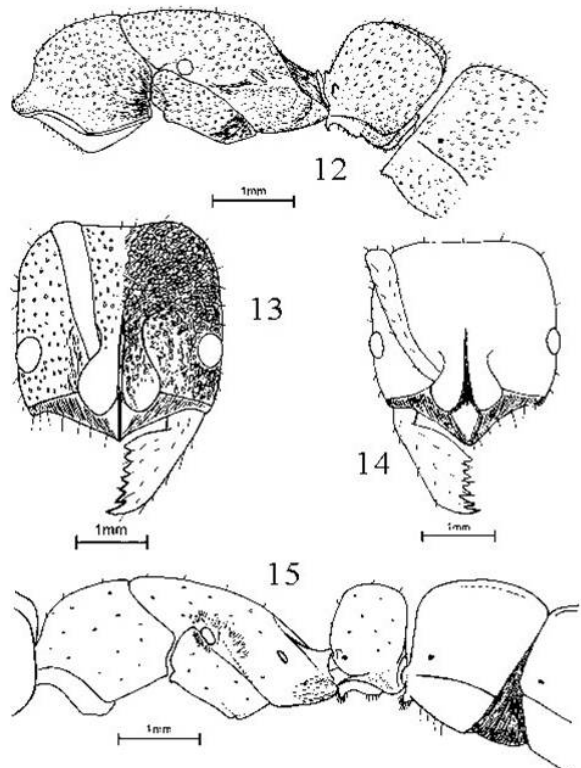
Fig 12 . The lateral view of worker of B. granosa (AMNH). Fig 13 . The head of worker of B. granosa (AMNH). Fig 14 . The head of the lectotype worker of B. laevissima (Iziko). Fig 15 . The lateral view of the lectotype worker of B. laevissima